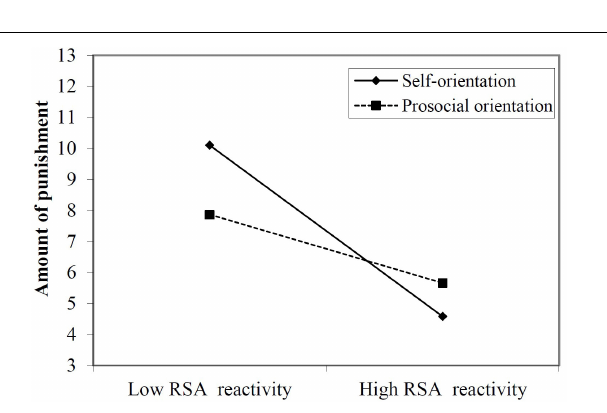
FIGURE 3 | Simple slope plots of RSA reactivity × social value orientation on amount of punishment in third-party punishment task.